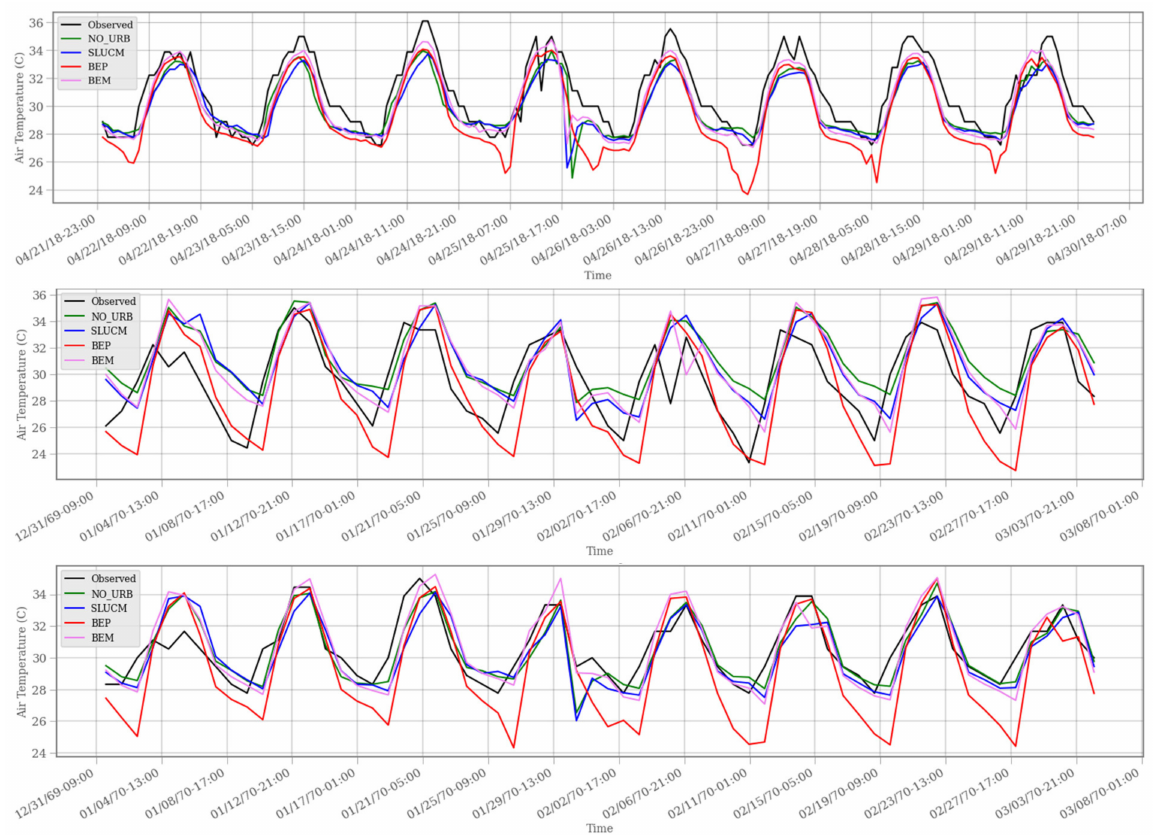
Figure 2. Temporal evolution of the observed and simulated air temperature ( ◦ C) at 2 m for NAIA ( top ), SGQ ( center ), and Manila Port ( bottom ). Simulation follows observed trend, although biases are observed notably at peak values. BEP performs poorly among the